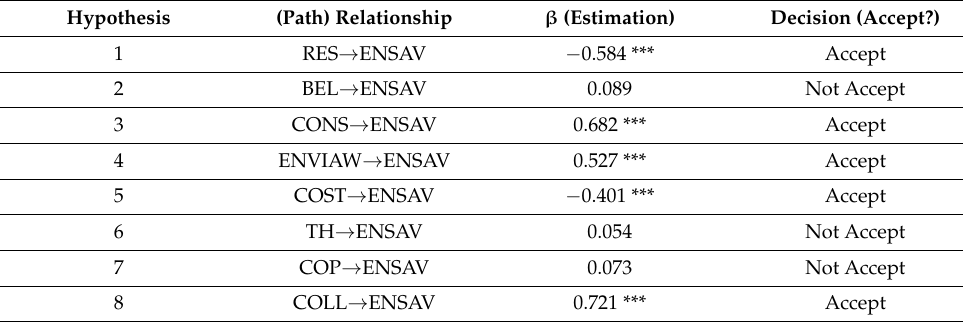
Table 3. Appraisal of the research